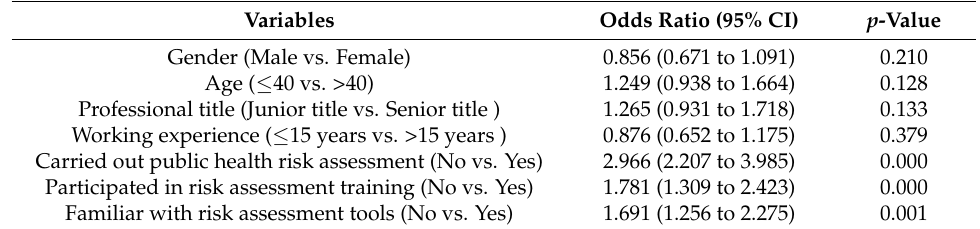
Table 2. Multivariate analysis between perceived competencies of risk assessment and characteristics of study